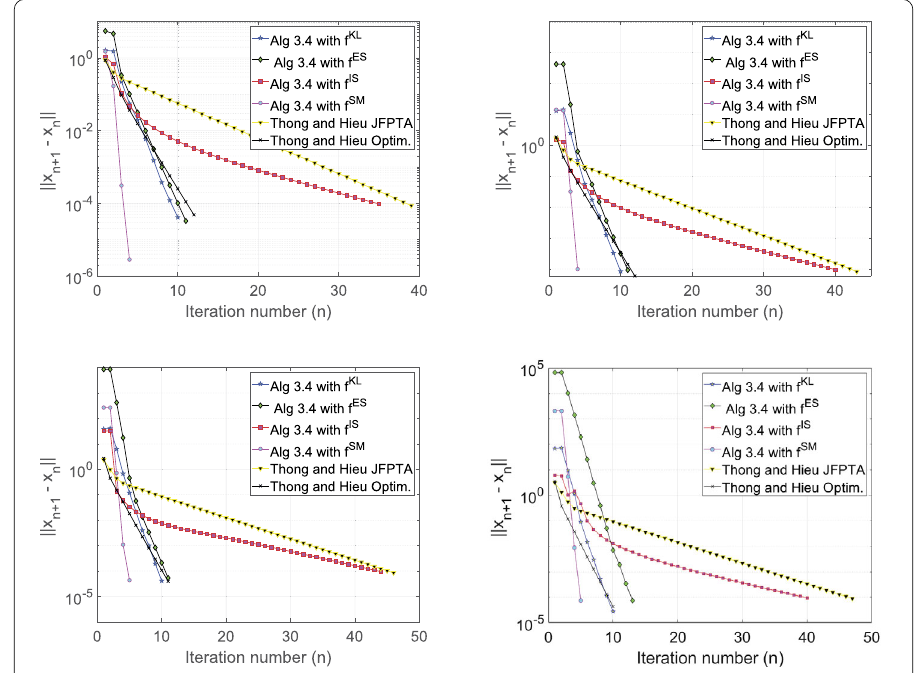
Figure 1 Experiment 1, top left: m = 5; top right: m = 20; bottom left: m = 50; bottom right: m =